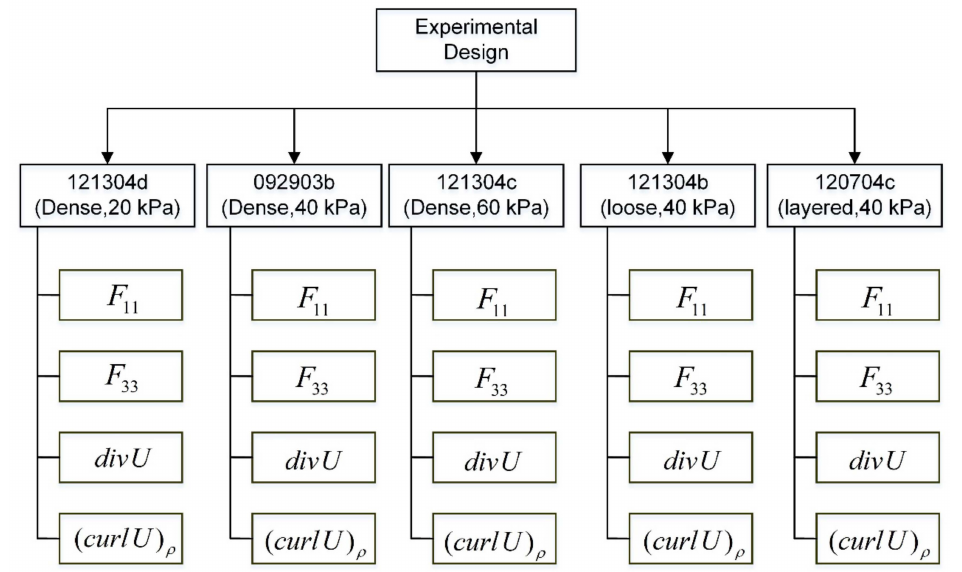
Figure 8. Experimental design of analyzing kinematic properties divergence; gradient along ˆ ρ axis ( F 11 ), gradient along ˆ y axis ( F 33 ), divergence ( div U ), and curl along ˆ ρ axis ( ( curl U )